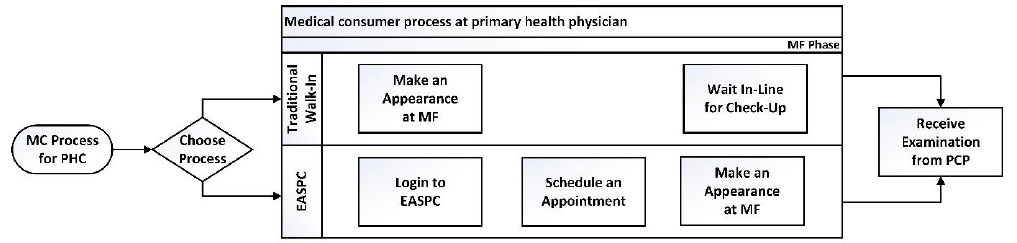
Figure 1. Flowchart of MC process comparison of traditional walk-in vs.